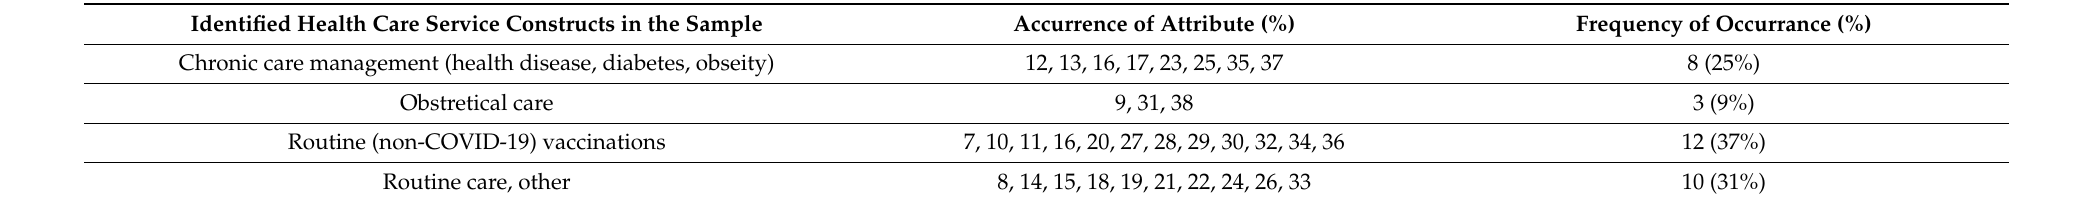
Table 2. Summary of Overall Health Care Service Constructs Identified ( n =